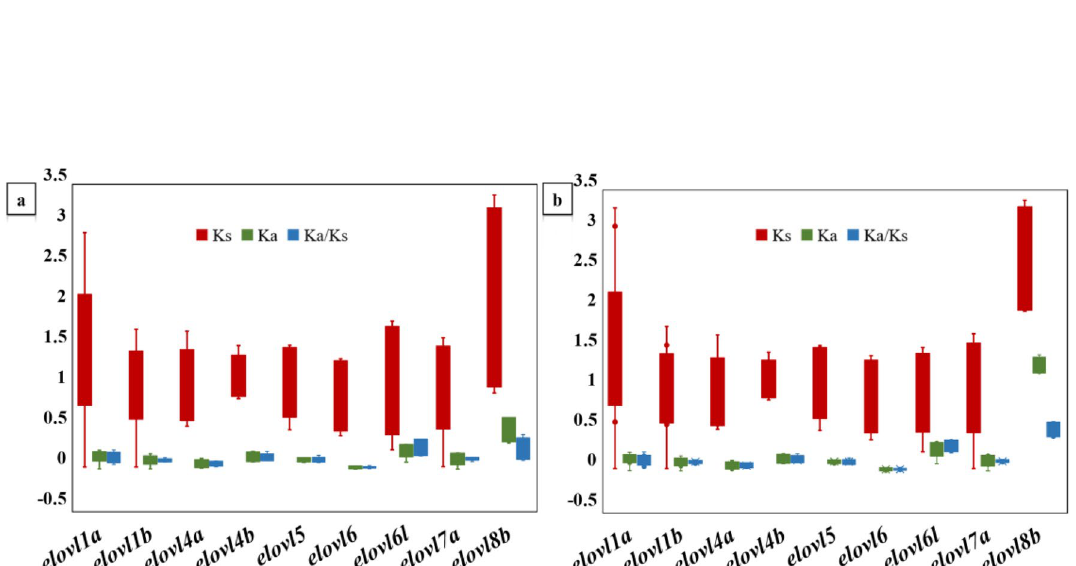
Figure 5. The evolutionary rates of the Elovl genes in ( a ) E. tetradactylum and ( b ) E. rhadinum . The Ka, Ks, and Ka/Ks values were demonstrated in boxplots with error